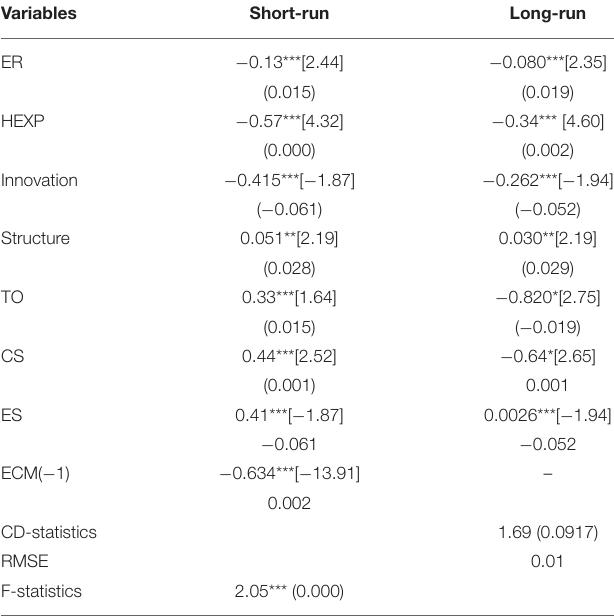
TABLE 5 | Augmented mean